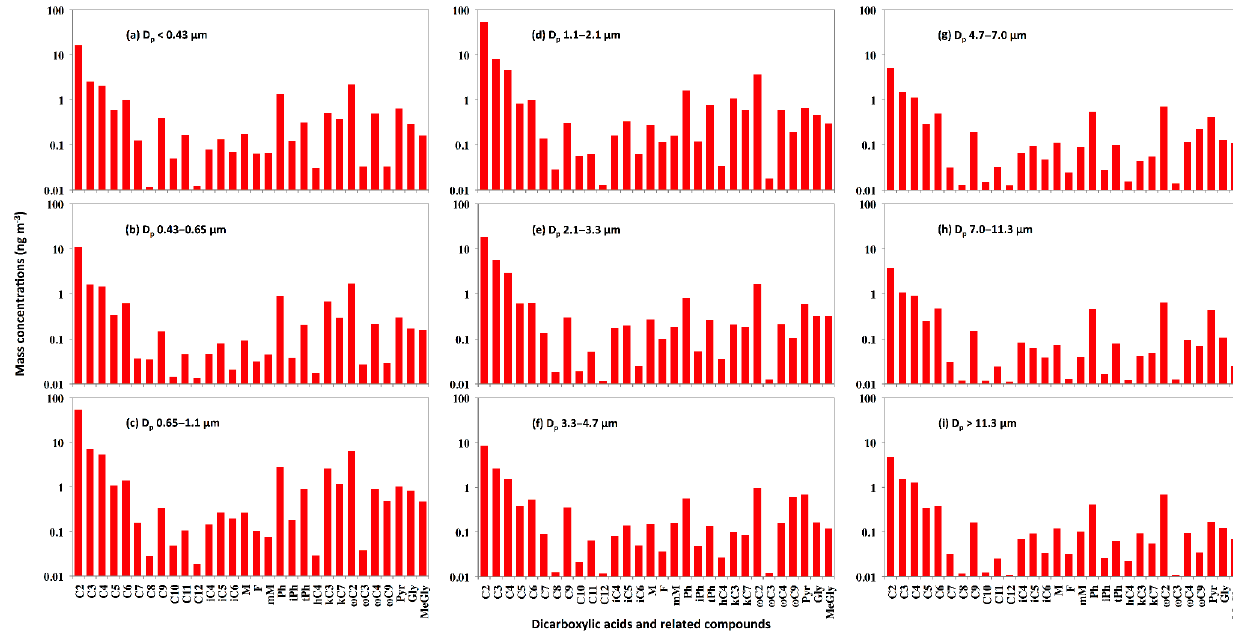
Figure 3. Average molecular distributions of water-soluble dicarboxylic acids and related compounds in size-segregated aerosols collected on Okinawa